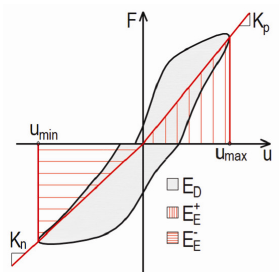
Fig. 9. Components and definition of the equivalent viscous damping coefficient ξ (Priestley et al. 1996)